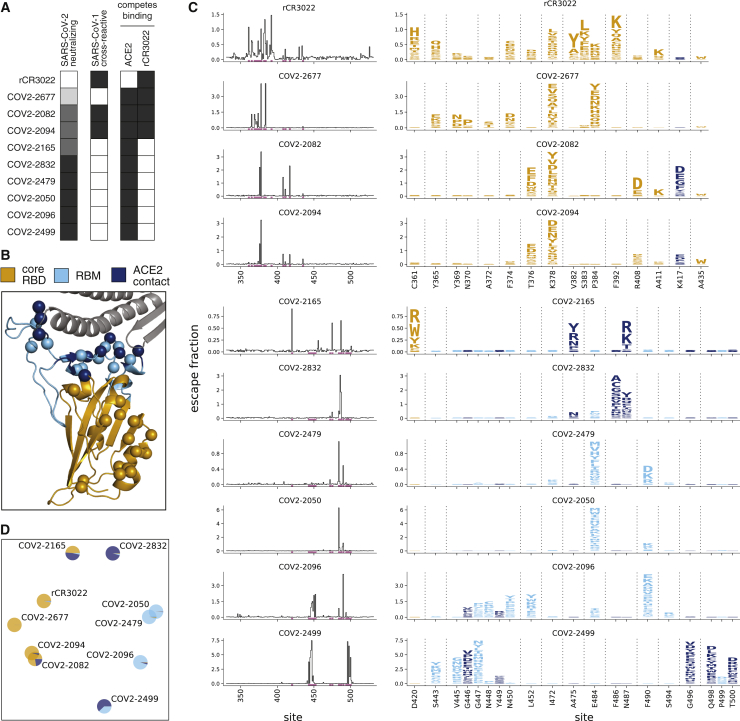
Complete Maps of Escape Mutations from 10 Human Monoclonal Antibodies(A) Properties of the antibodies as reported by Zost et al. (2020a). SARS-CoV-2 neutralization potency is represented as a gradient from black (most potent) to white (non-neutralizing). Antibodies that bind SARS-CoV-1 spike or compete with RBD binding to ACE2 or rCR3022 are indicated in black.(B) Structure of the SARS-CoV-2 RBD (PDB: 6M0J; Lan et al., 2020), with residues colored by whether they are in the core RBD distal from ACE2 (orange), in the receptor-binding motif (RBM, light blue), or in direct contact with ACE2 (dark blue). ACE2 is in gray. RBD sites where mutations escape antibodies are indicated with spheres.(C) Maps of escape mutations from each antibody. The line plots show the total escape at each RBD site (sum of escape fractions of all mutations at that site). Sites with strong escape mutations (indicated by purple at bottom of the line plots) are shown in the logo plots. Logo plots are colored by RBD region as in (B). Different sites are shown for the rCR3022-competing antibodies (top four) and all other antibodies (bottom six). For interactive escape maps, see https://jbloomlab.github.io/SARS-CoV-2-RBD_MAP_Crowe_antibodies.(D) Multidimensional scaling projection of the escape mutant maps, with antibodies having similar escape mutations drawn close together. Each antibody is shown with a pie chart that uses the color scale in (B) to indicate the RBD regions where it selects escape mutations. See also Figures S1 and S2 and Table S1.